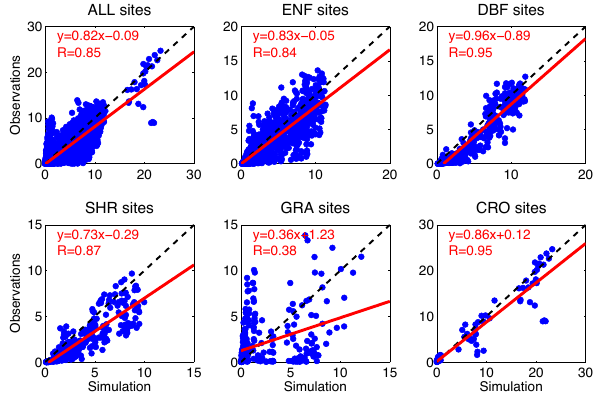
Fig. 1. Comparison between monthly average GPP in the YIBs simulations and NACP observations grouped by PFT type (where in situ measurements are available). The red lines indicate linear regression between observations and simulation results. The regression fits and correlation coefficients are shown on each panel. The land types include evergreen needleleaf forest (ENF), deciduous broadleaf forest (DBF), shrublands (SHR), grasslands (GRA), and croplands (CRO). The model-observation comparison for each site is shown in Fig. S4.